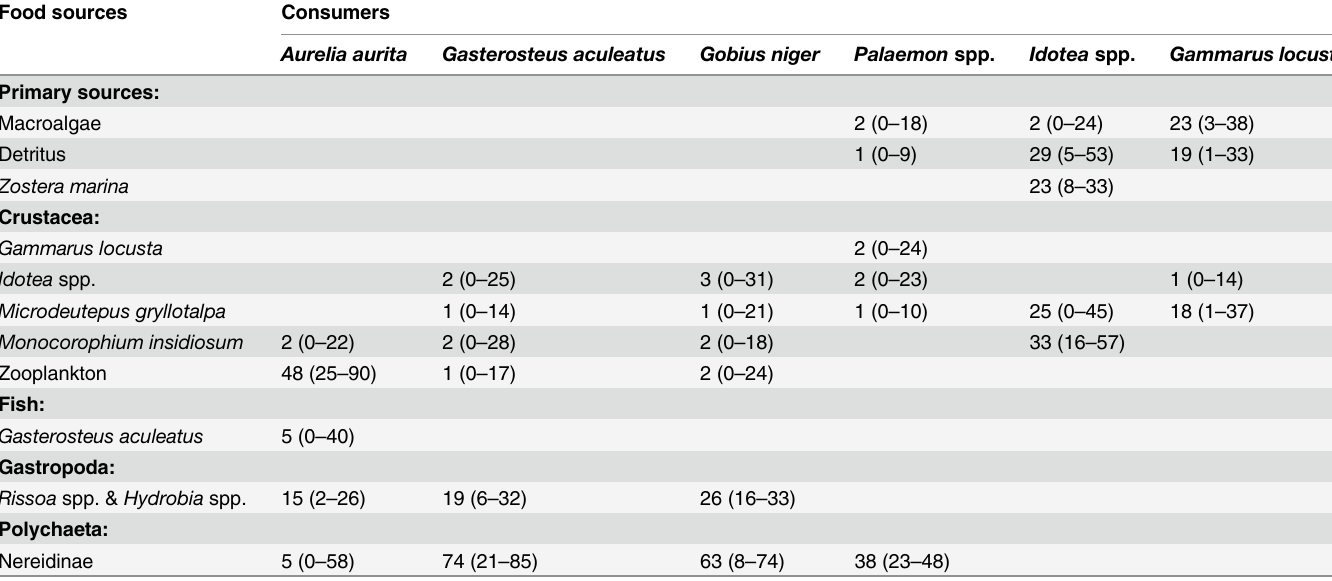
Table 6. Proportional (%) contribution of food sources to selected consumers in Kertinge Nor,